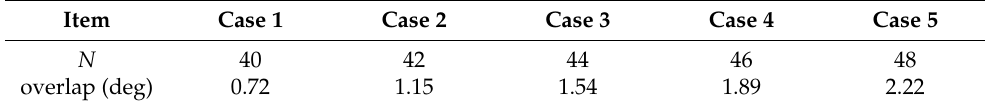
Table 3. Coverage overap between adjacent satellites in the same orbit.